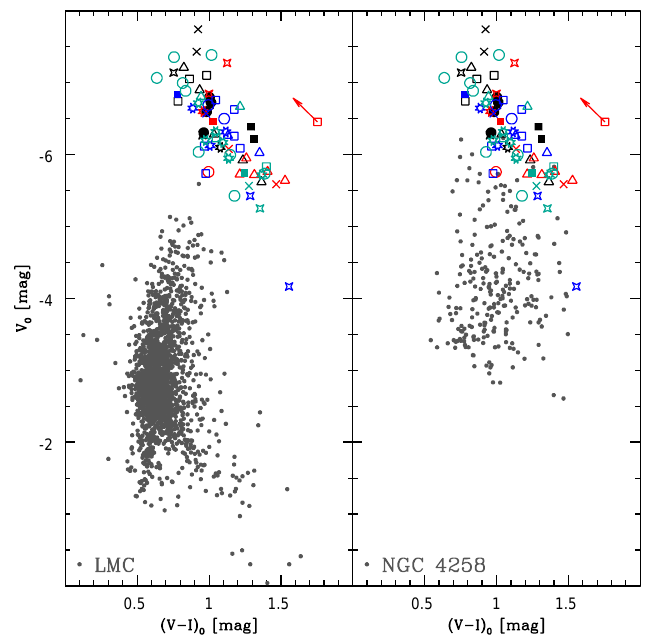
Figure 4. CMD V 0 versus ( V − I ) 0 for the ULPs in Table 1 compared on the left panel with the LMC OGLE CCs (grey dots) and on the right with the NGC 4258 ones (grey dots). The symbols for the ULPs are the same as those adopted in Figure 1. The red arrow indicates the position of H42 adopting the specific color excess derived by Taneva et al. [19] instead of the M31 one by Schlafly and Finkbeiner [35] reported in Table 1 (see text for